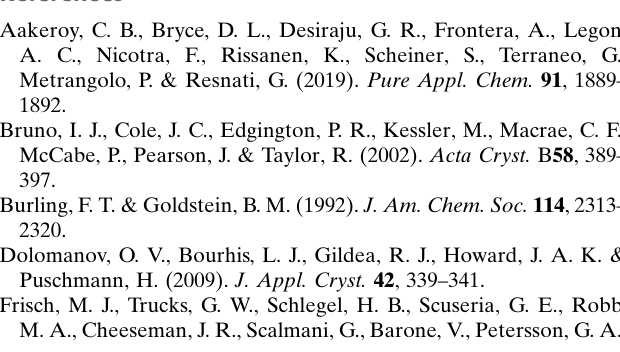
Table 3 Experimental details. Crystal data Chemical